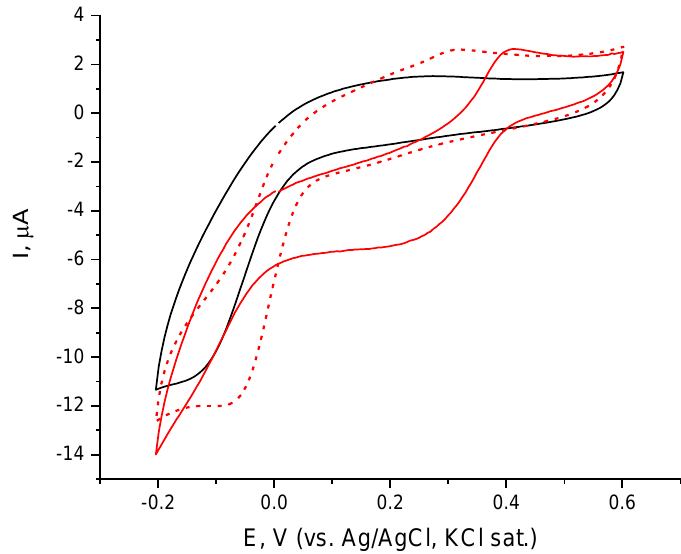
Figure 5. Cyclic voltammograms (second scan) of laccase electrode immobilized on chemisorbed monolayer of cystamine in background electrolyte (black, solid) and in dopamine (red, solid) and L -epinephrine (red, dash) present; concentration of catecholamines, C = 49.8 µM.